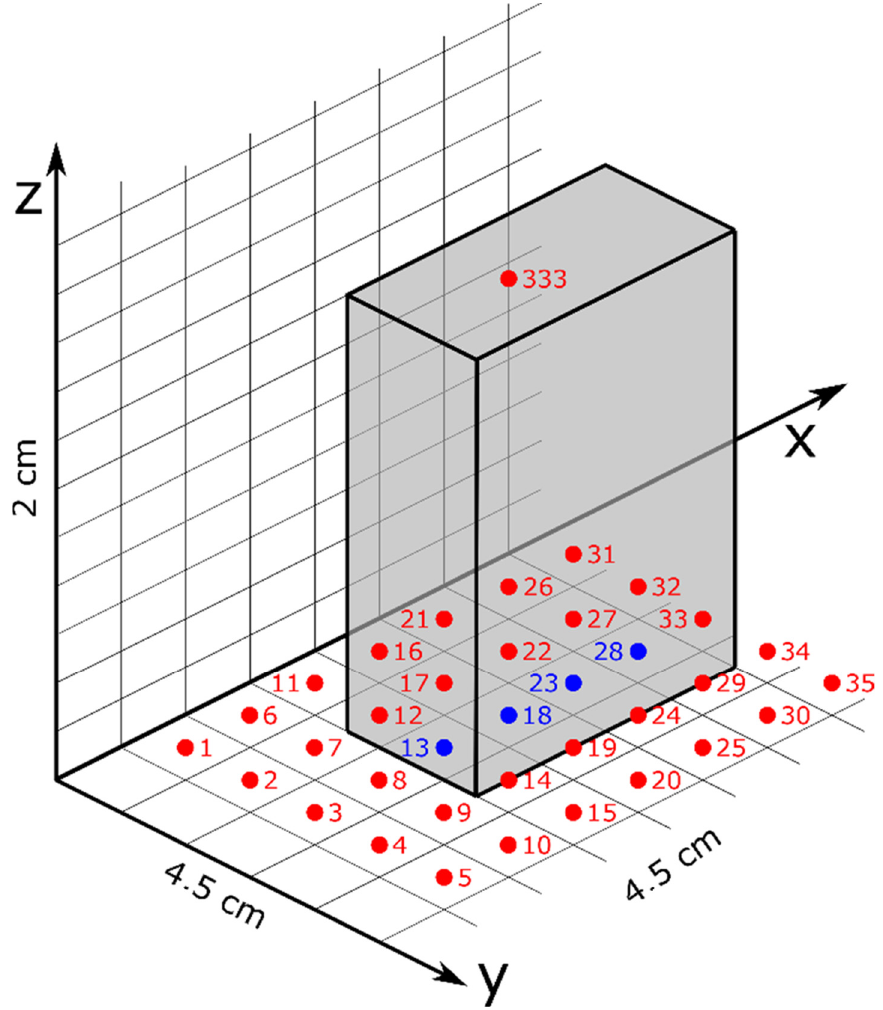
Figure 5. The measurement grid defined around a railway relay (gray) figuring some of the directly measured points (red) and some of the indirectly measured points (blue).